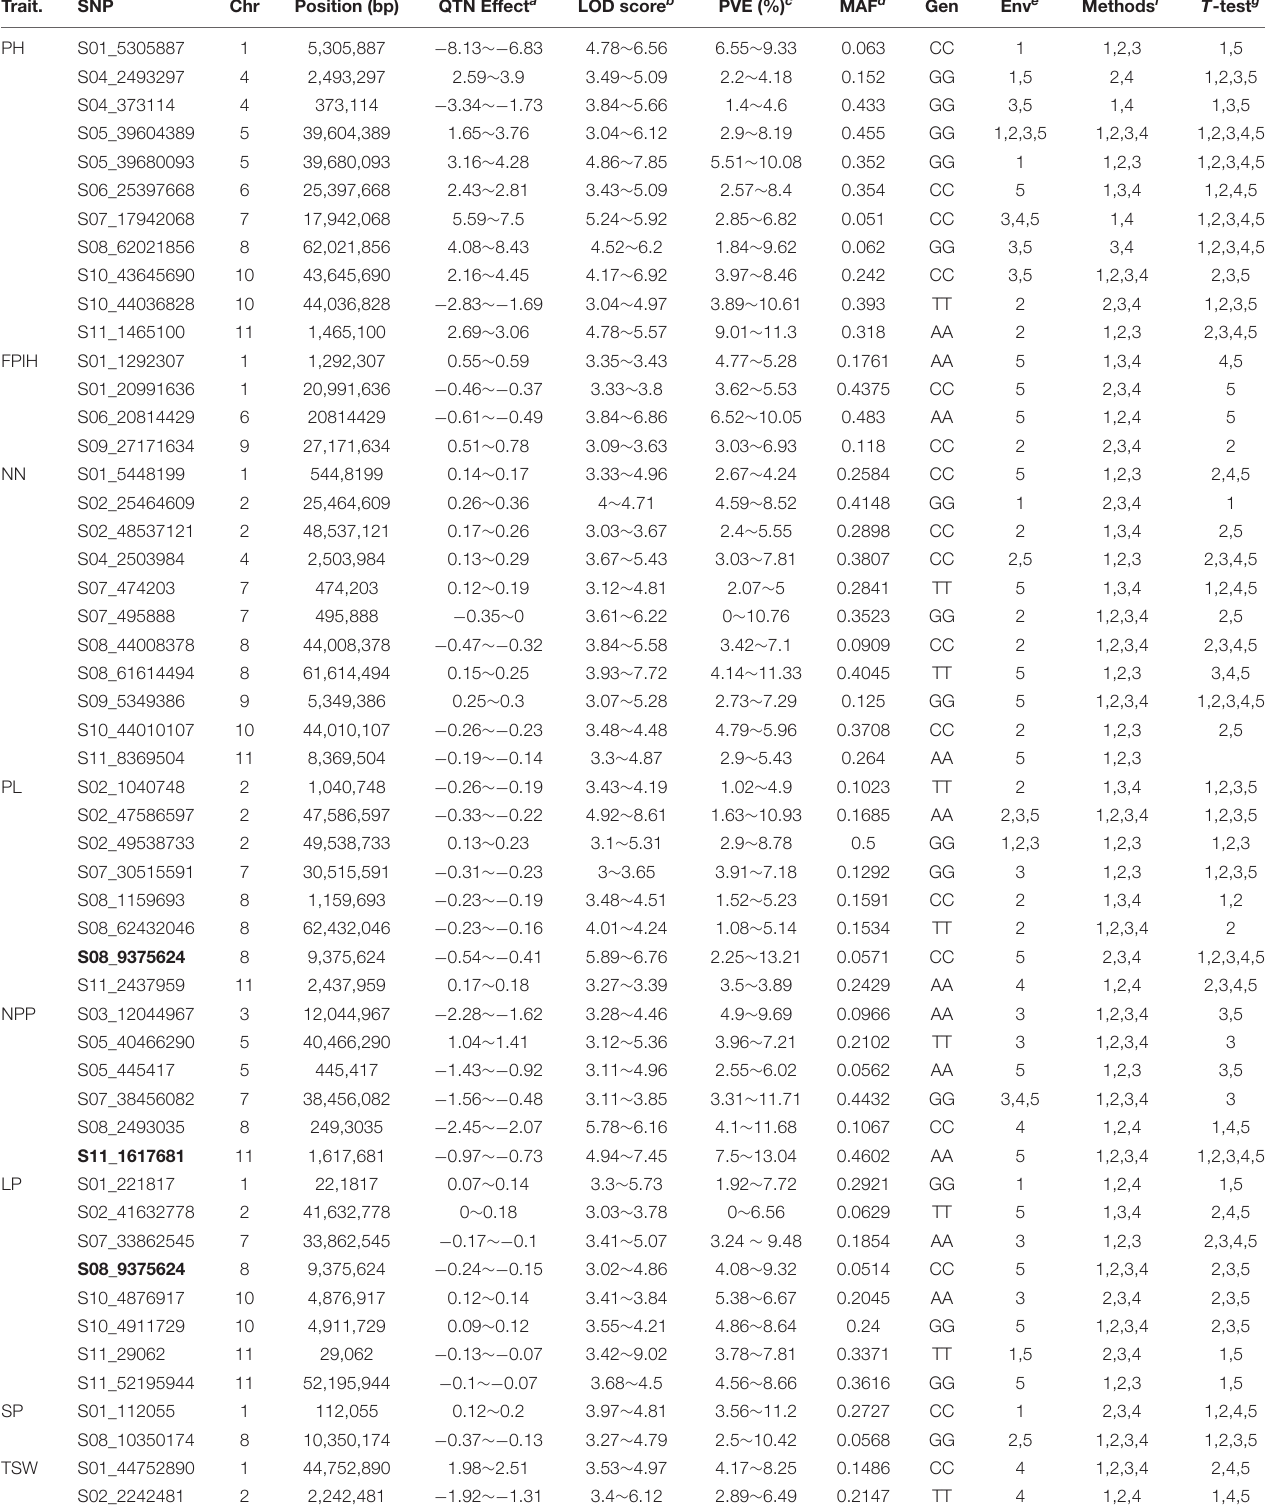
TABLE 2 | QTNs associated with morpho-agronomic traits detected at least three times via different methods and in different environments in common bean accessions belonging to the Brazilian Diversity Panel (BDP).